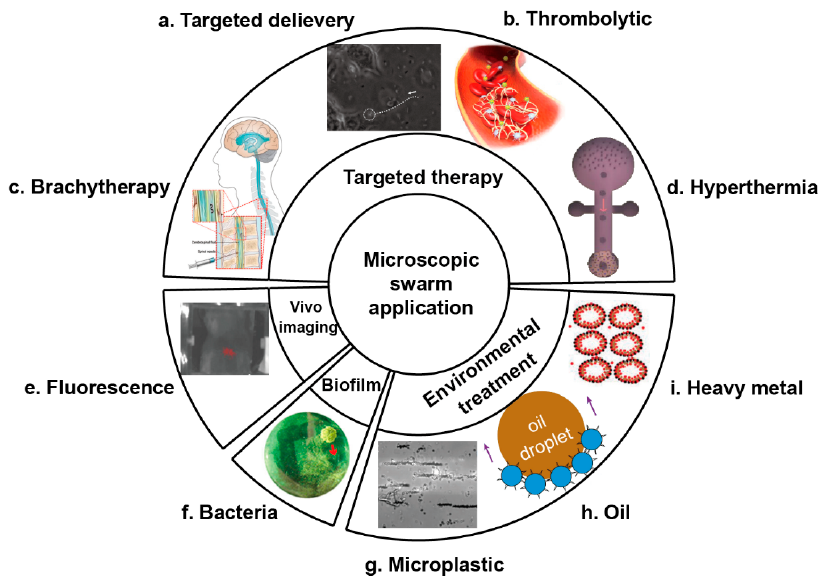
Figure 7. Schematic illustration of microscopic swarm application. ( a ) Targeted delivery of bacteria- driven microswimmers under directional guidance toward cancer cells. Reproduced with permission from [107]. Copyright 2017 American Chemical Society. ( b ) Nanoparticles used in phase transition thrombolysis. Reproduced with permission from [108]. Copyright 2019 American Chemical Society. ( c ) Helical microswimmer in brain brachytherapy. Reproduced with permission under a